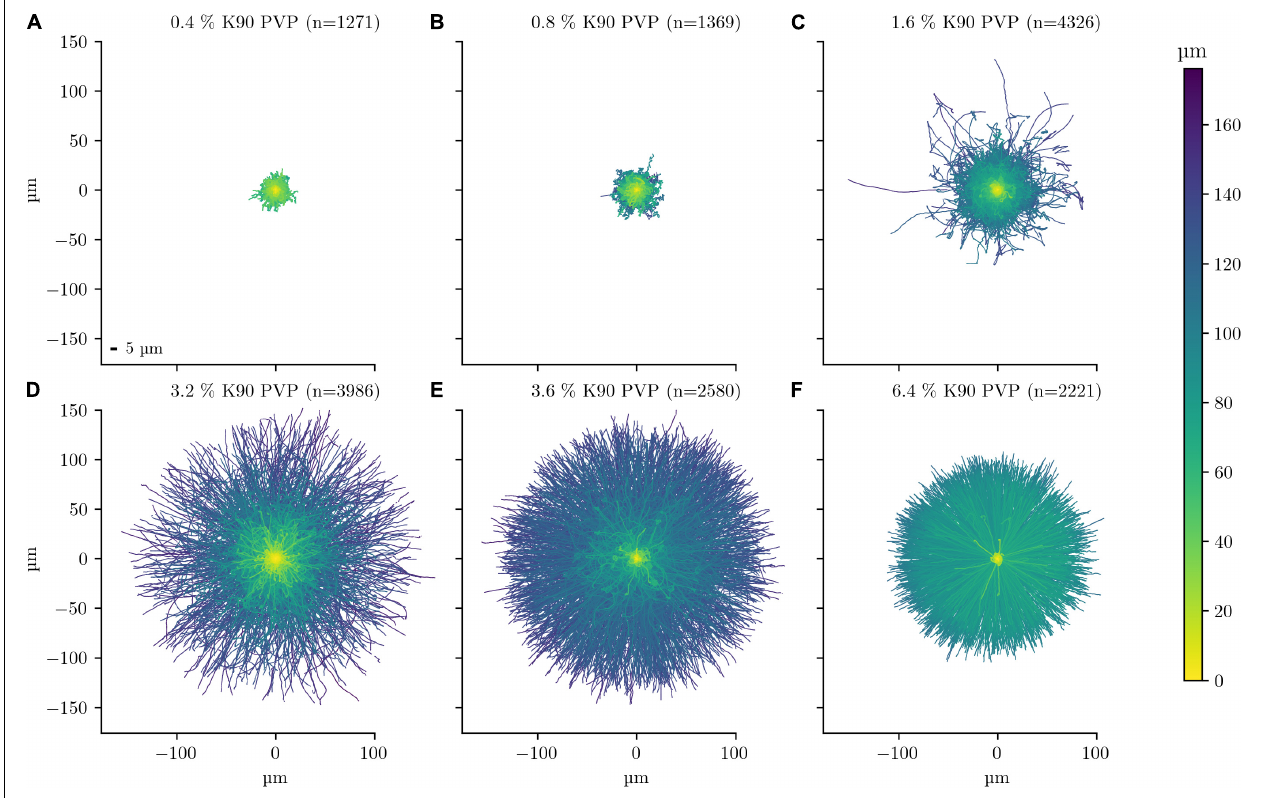
FIGURE 1 | Single cell motility dependency on PVP of C. difficile 630 (cid:49) erm . The motility of C. difficile cells was tracked in the presence of six increasing K90 PVP concentrations (w/v) from 0.4 to 6.4% (A–F) . All observation durations were limited to 10 s for better comparability. The number of displayed tracks is stated in the title of each experiment. The starting position of each track is at the origin of the plot at position 0 µ m/0 µ m. The scale is identical for all six plots. Track colours denote the total travelled distance, with a colour bar on the right-hand side as a legend. A 5 µ m scale bar is depicted in the lower left of subfigure (A) . The median cell lengths of C. difficile was determined to be between 4.3 and 5.7 µ m ( Supplementary Table 1